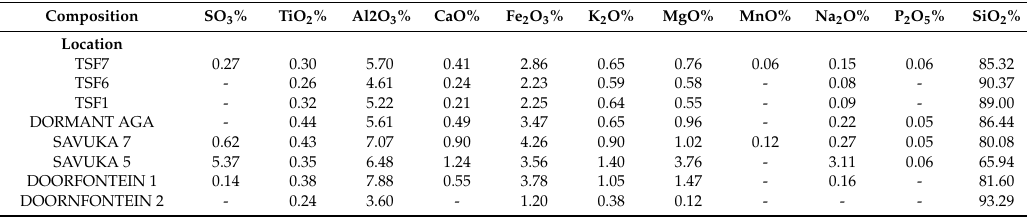
Table A6. XRF results for tailings storage